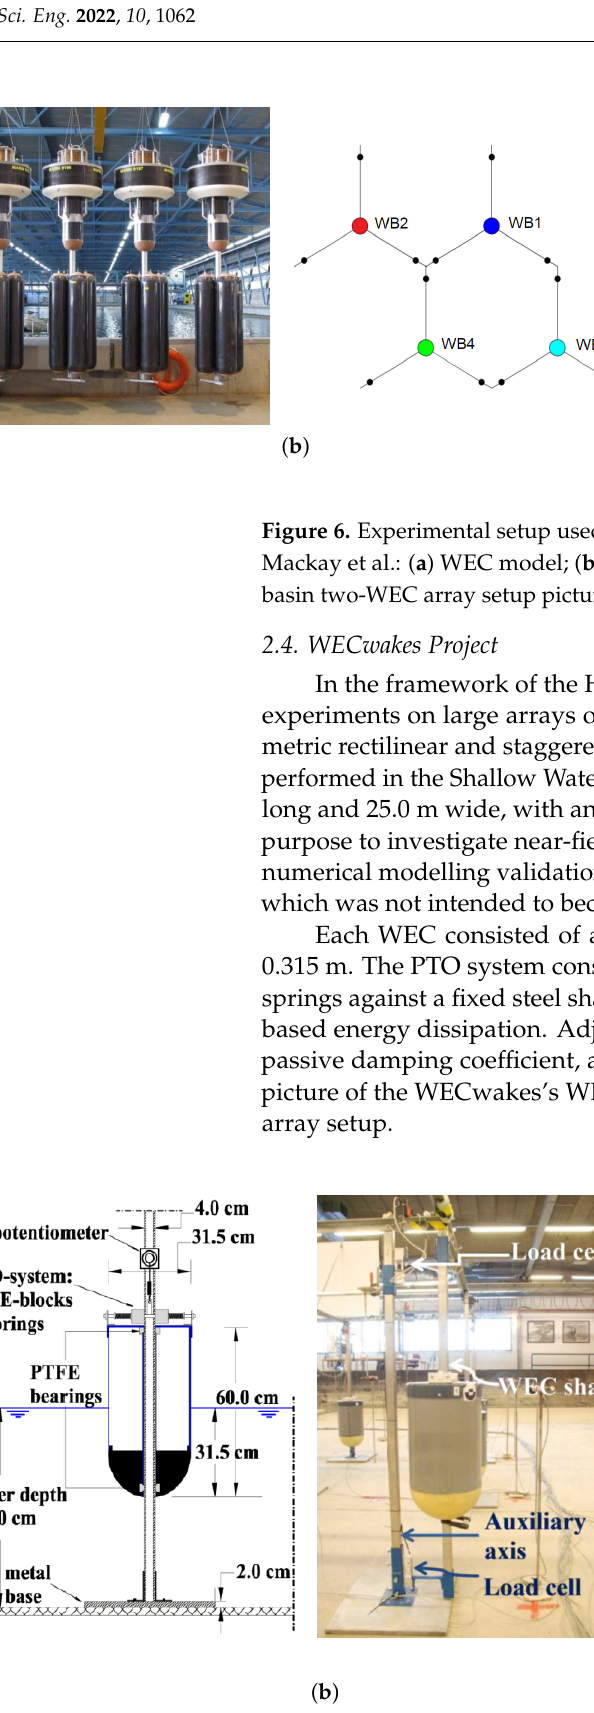
Figure 7. Experimental setup used by Stratigaki et al., reprinted with permission from Ref. [10], 2014, Stratigaki et al.: ( a ) WEC model; ( b ) WEC model; ( c ) DHI’s Shallow Water Wave Basin